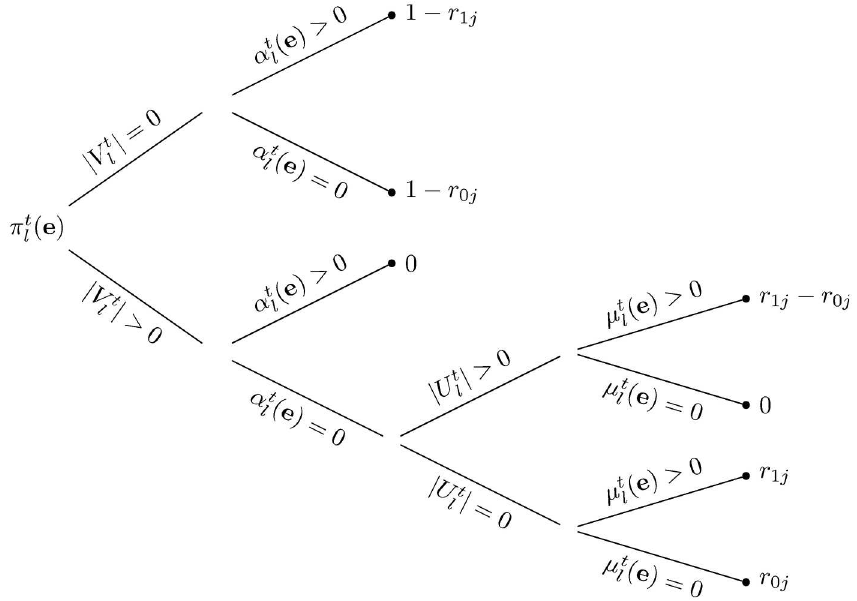
Fig 1. A graphical depiction of Eq